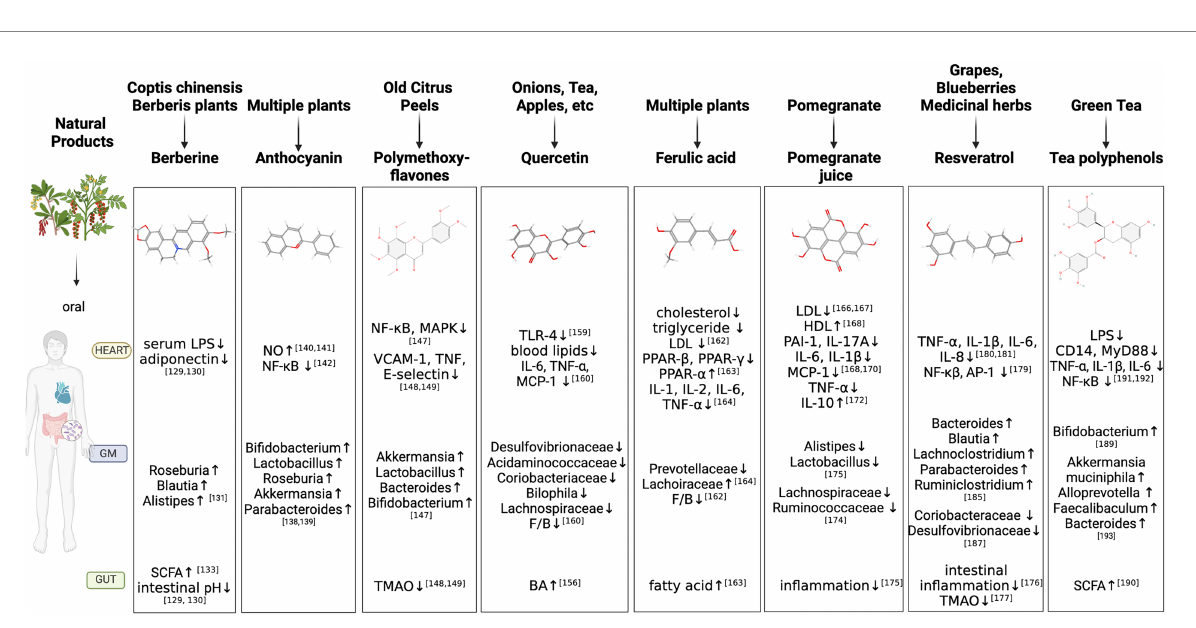
FIGURE 2 Natural Products regulate GM-inflammation axis in AS. GM, gut microbiota; LPS, Lipopolysaccharide; SCFA, Short-Chain Fatty Acids; NO, nitric oxide; VCAMs, vascular cell adhesion molecules; TNF, tumor necrosis factor; NF- κ B, NF-kappa B; MAPK, mitogen-activated protein kinase; TMAO, Trimethylamine N-oxide; TLRs, Toll-like receptors; IL, interleukin; MCP, monocyte chemotactic protein; F/B, Firmicutes/Bacteroidetes; BA, Bile acids; LDL, Low density lipoprotein; PPAR, peroxisome proliferators-activated receptor; IL, interleukin; HDL, high density lipoprotein; PAI-1, plasminogen activator inhibitor-1; AP-1, activator protein-1; ↑ , increase; ↓ ,